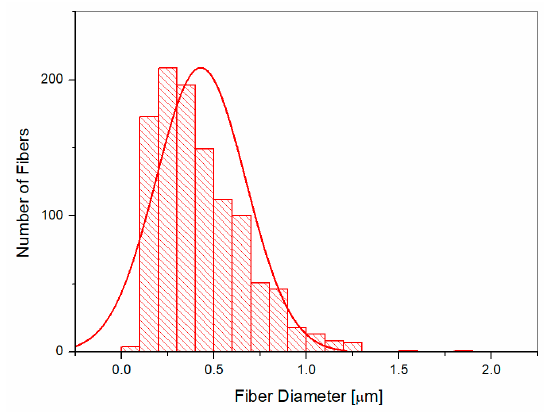
powders’ diffractogram is shown for comparison (dotted line).